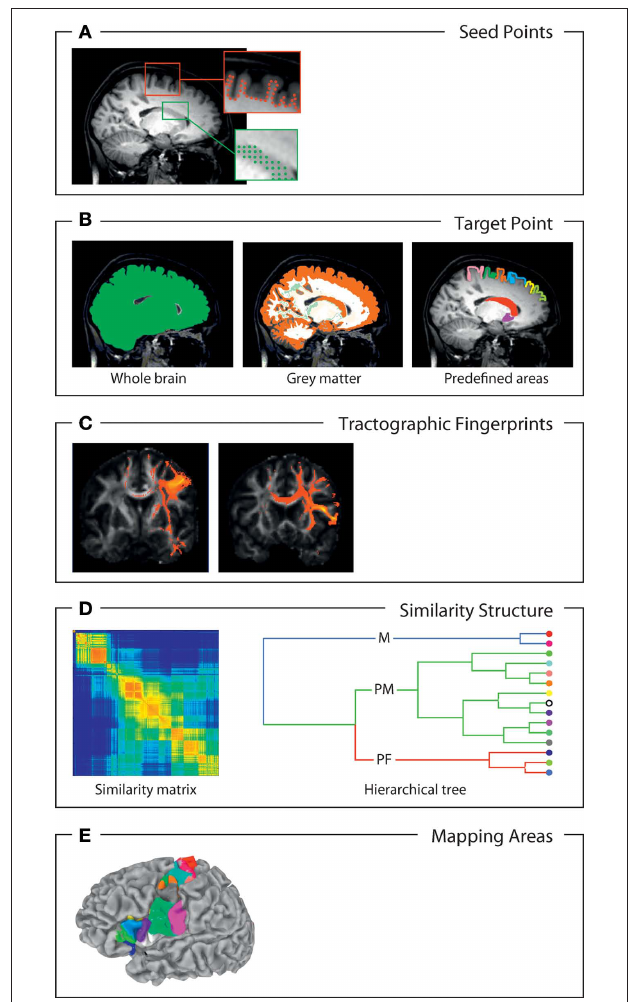
Figure 3 | Schematic overview of the main operations involved in connectivity-based gray matter parcellation. (A) Definition of seed points. The seed points discretize the region of interest to be parcellated. This may, for example, be the cortical mantle or a section thereof, represented by the points at the gray–white matter interface (red dots, e.g., Anwander et al., 2007), or a sub-cortical structure like the caudate. As such sub-cortical structures are penetrated by fibers much more than the cortex, the use of all voxels as seed points is warranted (green dots, e.g., Behrens et al., 2003). (B) Definition of the target space. The target space determines to which voxels or regions the connectivity from the seed voxels will be computed. For example, one may simply use the entire brain (top, e.g., Johansen-Berg et al., 2004), or just a certain part of the brain (e.g., Bach et al., 2011), such as the cortex or all gray matter (middle) or a collection of predefined regions (e.g., Behrens et al., 2003b), e.g., based on macroscopic landmarks (bottom). (C) Connectional fingerprints: the fingerprints comprise the connectivity of each seed voxel with all target voxels or regions. They can be estimated in various ways. Here, as an example, probabilistic tractograms connecting the seed voxel with all other voxels of the brain are depicted. (D) Similarity structure: similarity between different connectional fingerprints can be measured in different ways, for example, as correlation, as Euclidean distance (after normalization) or as mutual information. It can be represented as similarity matrix (top) or hierarchical cluster tree (bottom). (e) Parcellation mapped on the brain: clustering or partitioning algorithms extract sensible parcellations from the similarity structure, which can then be mapped on the brain. Here, we show a cortical parcellation computed with an agglomerative clustering method (Gorbach et